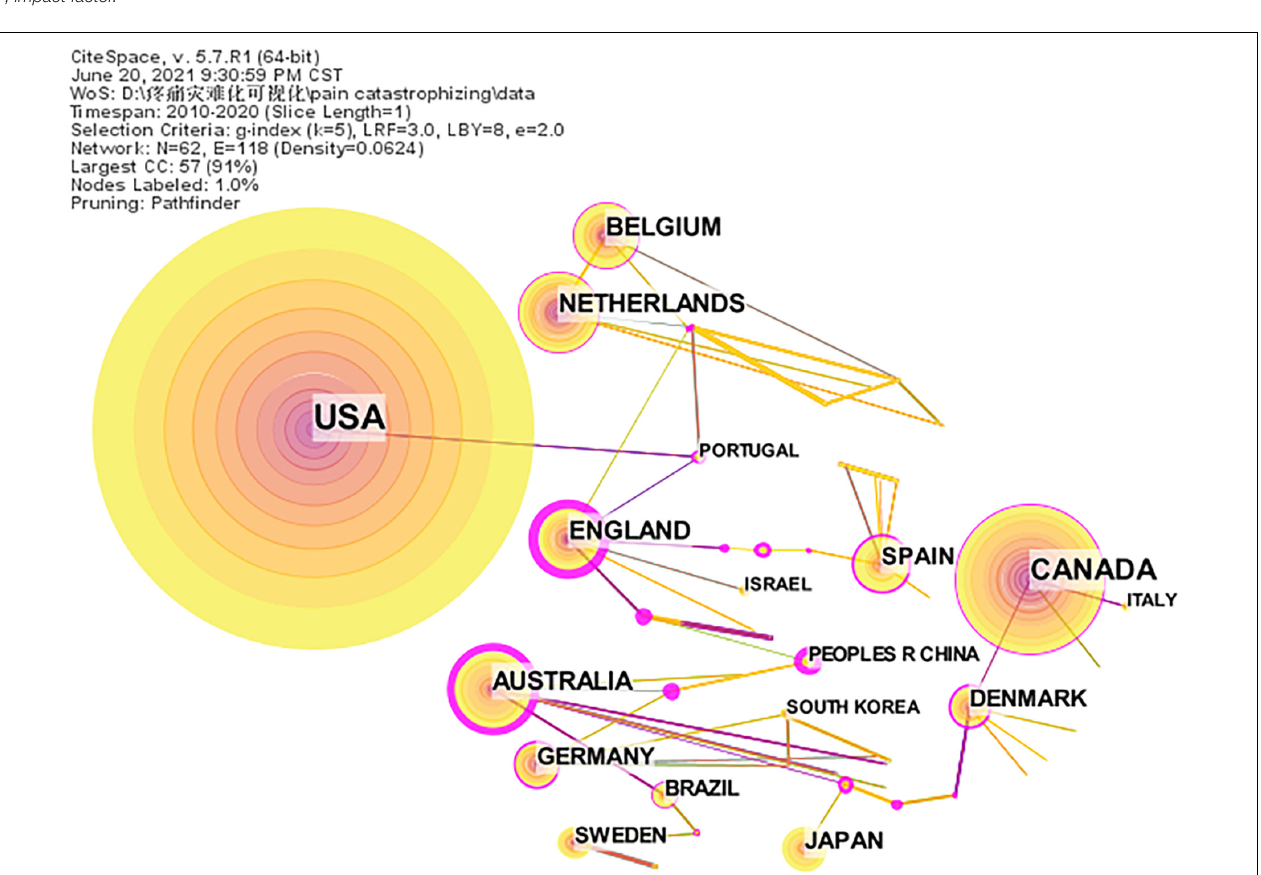
FIGURE 2 | A country cooperation map related to pain catastrophizing from 2010 to 2020. The nodes in the map represent countries. The lines between the nodes represent cooperation relations.